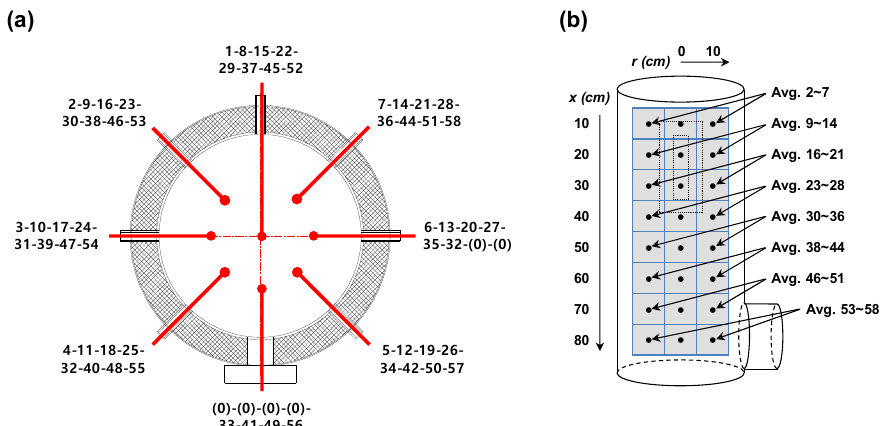
Figure 3. Thermocouple positions in the combustion chamber in top view ( a ), temperature averaging in 2D axisymmetry ( b ).